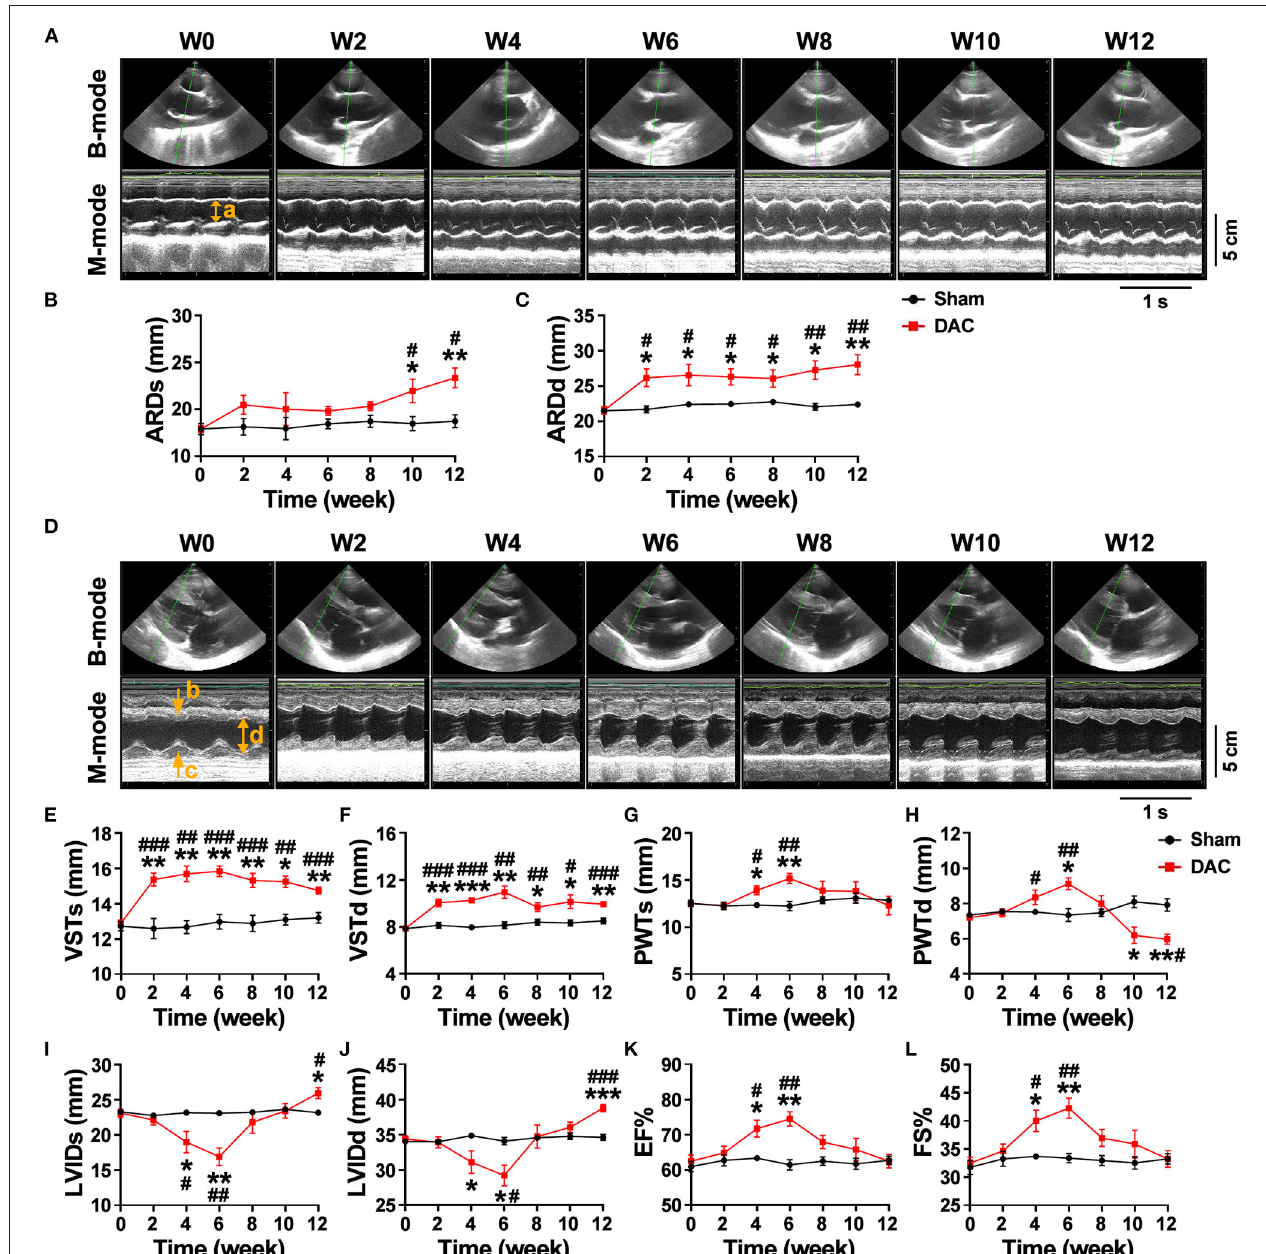
FIGURE 2 | Echocardiography of the sham and DAC animals. B-mode and M-mode of the aortic root (A) and left ventricle (D) at weeks 0, 2, 4, 6, 8, 10, and 12. Following DAC surgery, the diameters of aortic roots at systole (ARDs) and diastole (ARDd) were increased following DAC (B,C) . The thicknesses of the intraventricular septum at systole (VSTs) and diastole (VSTd) and were significantly increased over time (E,F) . The thickness of posterior wall at systole (PWTs) and diastole (PWTd) in the DAC group were gradually increased after week 2, but decreased after week 8 (G,H) . Changes in the left ventricular internal dimension at systole (LVIDs) and diastole (LVIDd) displayed a pattern with a “V” shape over time after surgery (I,J) . The left ventricular ejection fraction (EF) and fractional shortening (FS) in the DAC groups were preserved, compared with those of the sham groups at the corresponding time points (K,L) . ARD (a), VST (b), PWT (c), and LVID (d) were indicated in M mode images of (A) and (D) . n = 4 minipigs per group. All data are presented as the means ± SEMs. * P < 0.05, ** P < 0.01, *** P < 0.001 vs. the sham group; # P < 0.05, ## P < 0.01, ### P < 0.001 vs. the week 0.